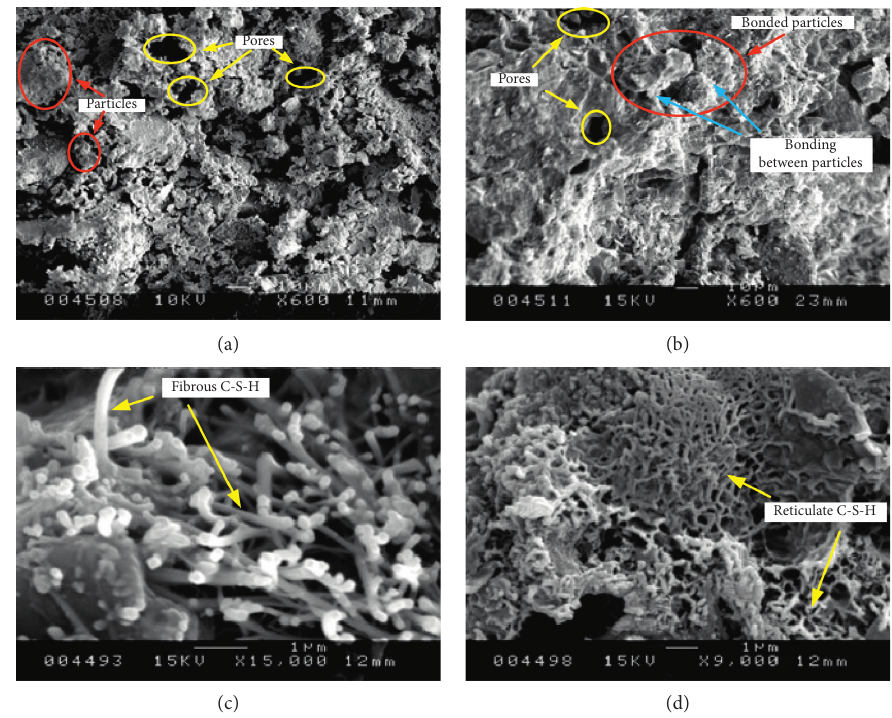
Figure 6: SEM test results of LF-YRAS and C2: (a) LF-YRAS, standard curing for 7d, 1:600; (b) C2, standard curing for 7d, 1:600; (c) C-S-H in C2, standard curing for 7 d, 1:15000; (d) C-S-H in C2, standard curing for 7d,